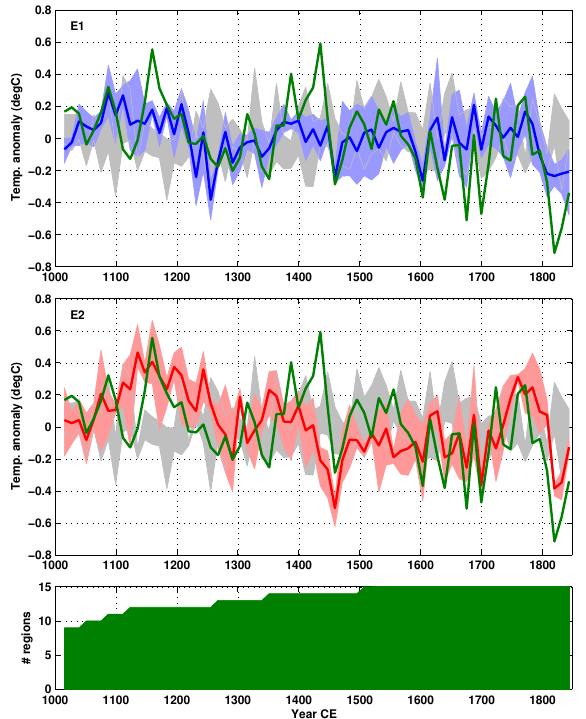
Figure 7. Time series illustration of data used for the U R and U T analysis at the 12-year time unit. Green curves show the arithmetic average of all calibrated proxy series ( z series). Blue and red curves show the corresponding values for simulated multiple-forced tem- peratures ( x series), averaged over the low solar (E1, blue) and high solar (E2, red) ensemble members. Light-blue and light-red bands show the range between the highest and lowest regionally averaged simulated temperatures within the E1 and E2 ensembles. Grey bands show the corresponding range for the control simula- tion ensemble. Temperatures are shown as anomalies with respect to long-term averages, as used for the U R and U T calculations. The bottom graph shows how the number of regions change with